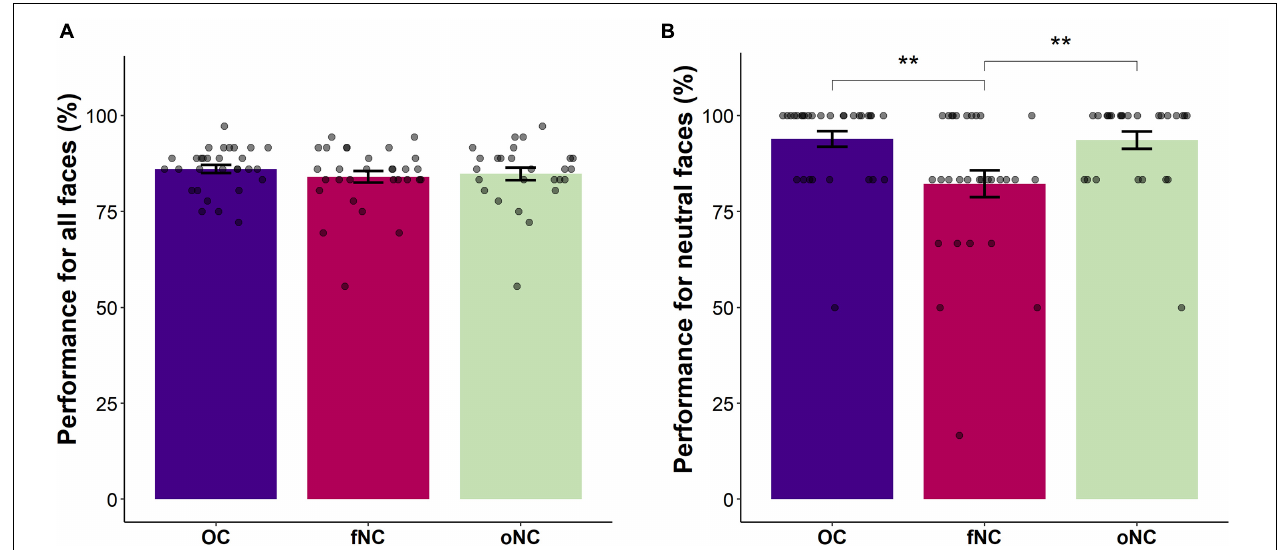
FIGURE 2 | Bar chart depicting the (A) overall emotion recognition accuracy (in percent) and (B) the emotion recognition accuracy for neutral faces (in percent) per group [i.e., OC – oral contraceptive users (blue), fNC – naturally cycling women in early follicular phase (magenta), and oNC – naturally cycling women in periovulatory phase (light green)]. Error bars with 1 SE. ** p <